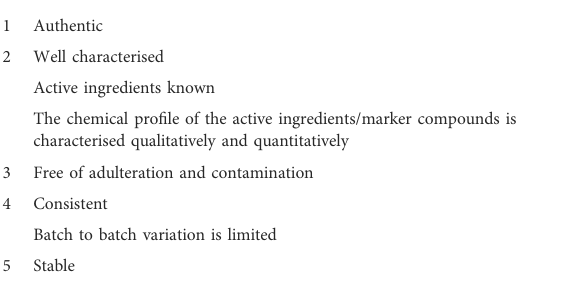
TABLE1Characteristicsoftheidealmedicinalplantextractorproduct used in pharmacological, toxicological and clinical/intervention